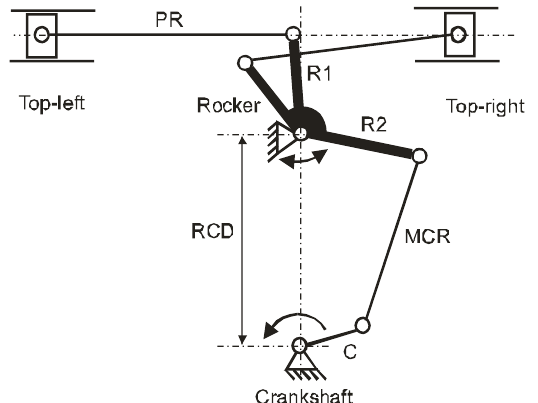
Fig. 3. Kinematic diagram of the 2-cylinder rocker engine